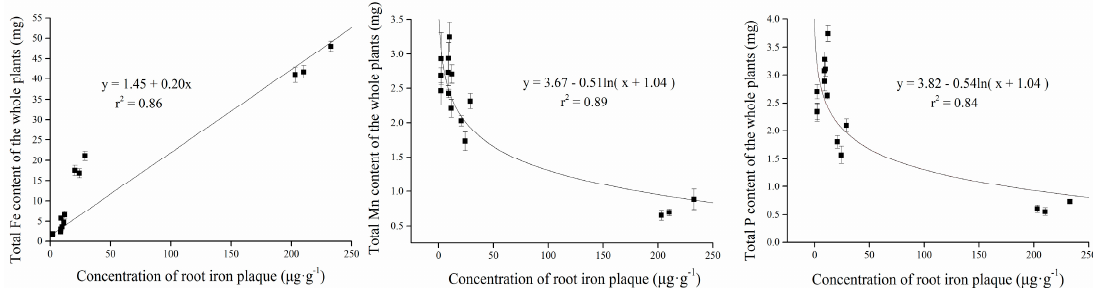
Figure 7. Relationship between the concentration of root iron plaque and total Fe content, total P content, and total Mn content of the whole plant. Data were means ± SE ( n = 3).